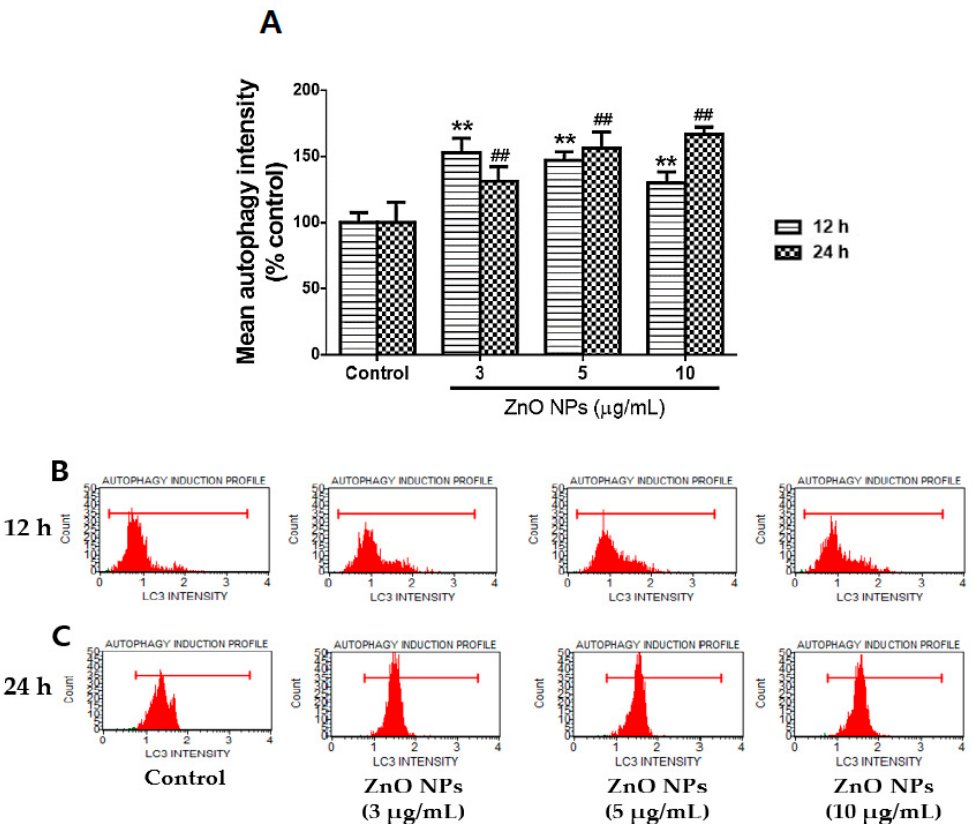
Figure 4. E ff ects of ZnO NPs on autophagic LC3 intensity in primary cultured astrocyte cells. Mean autophagy intensity gradually increased at toxic concentrations of ZnO NPs at 12 h and 24 h ( A ). Representative flow cytometry data for the control and ZnO NPs (3 µ g / mL, 5 µ g / mL, and 10 µ g / mL) at 12 h ( B ) and 24 h ( C ). Data represents the mean ± SEM. ** p < 0.01 and ## p < 0.01 compared to the respective controls ( n = 4).